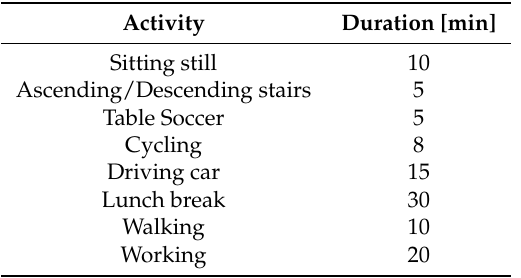
Table 1. Data collection protocol: activities and their duration.